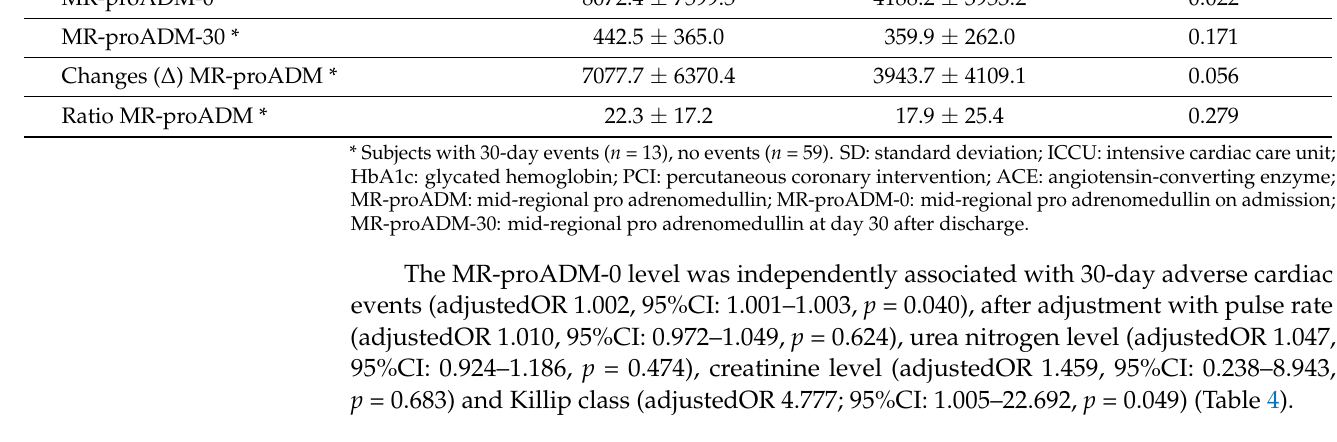
Table 4. Univariate and multivariable analysis for 30-day follow up adverse cardiac